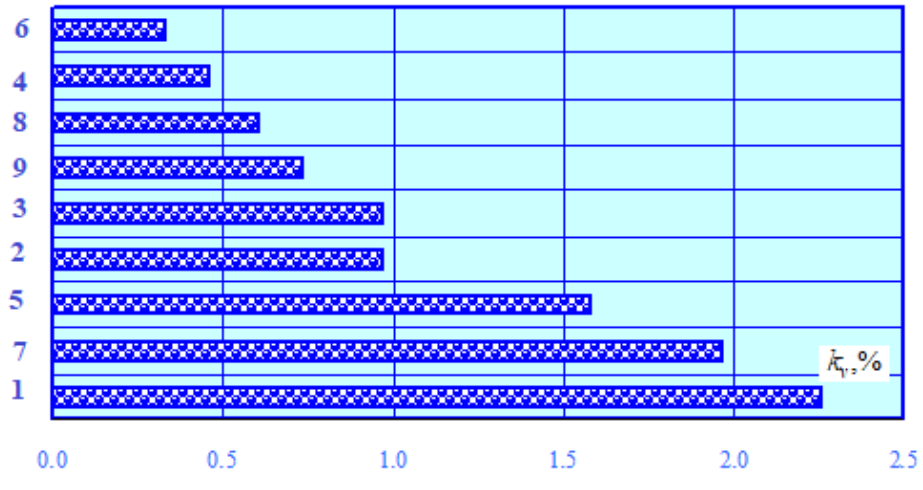
 ; σ is the E max Ek = ;  is the v max